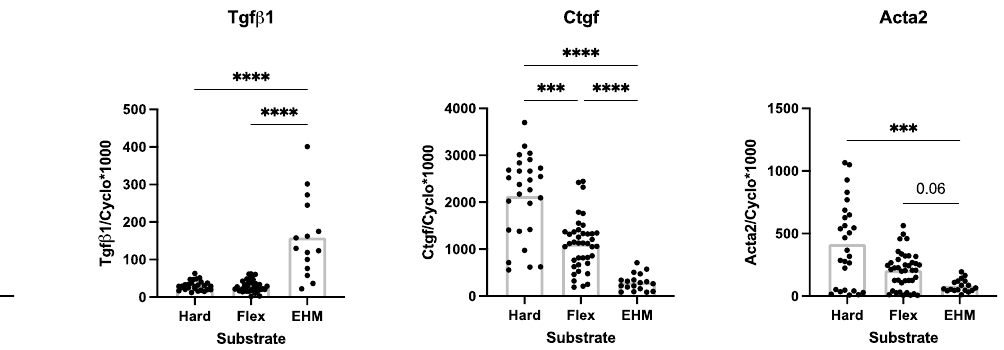
Figure 6. Baseline gene expression levels of Nppb, Tgfβ1, Ctgf and Acta2 in CF cultured on the different substrates: 2D monolayer on hard plastic cell culture plates (Hard), 2D monolayer on Bioflex cell culture plates (Flex) and 3D EHM fibers (EHM). Data are presented as relative mRNA levels normalized to house-keeping gene cyclophylin ( n = 15–40). *** p < 0.001; **** p < 0.0001. Bar indicates mean.